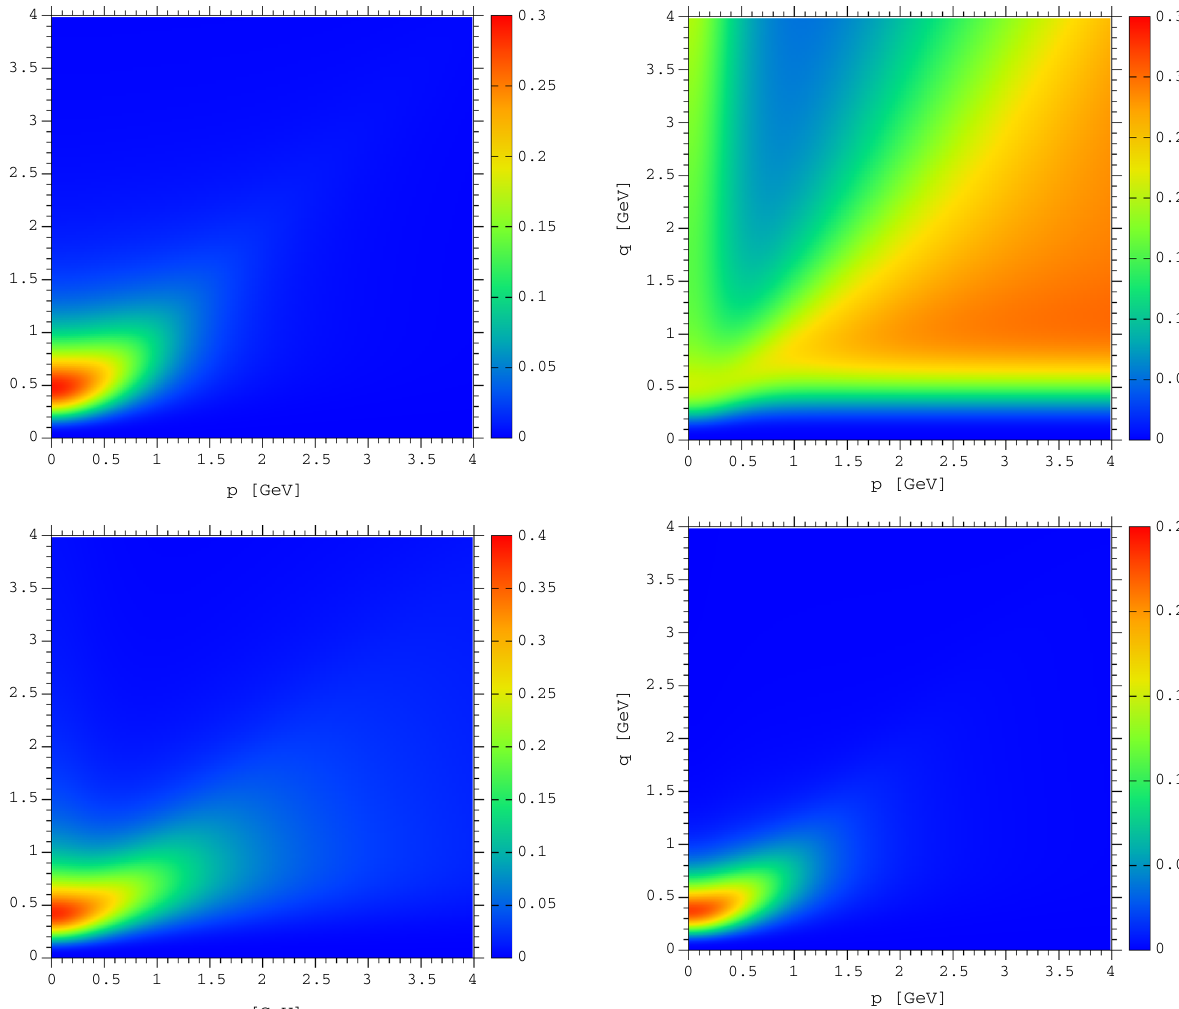
( p , q ) and vector (bottom) B